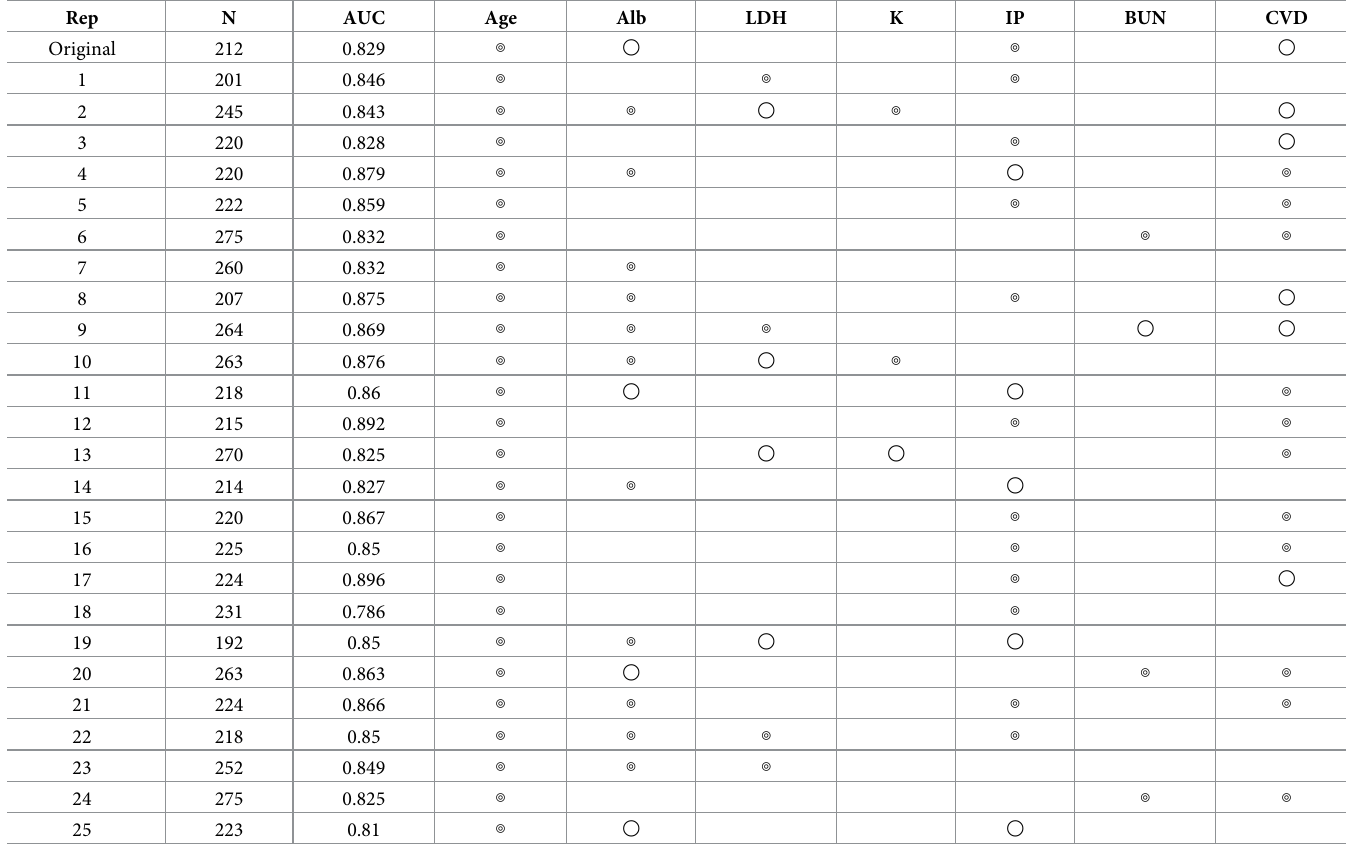
Table 3. Reproducibility of the prediction model by